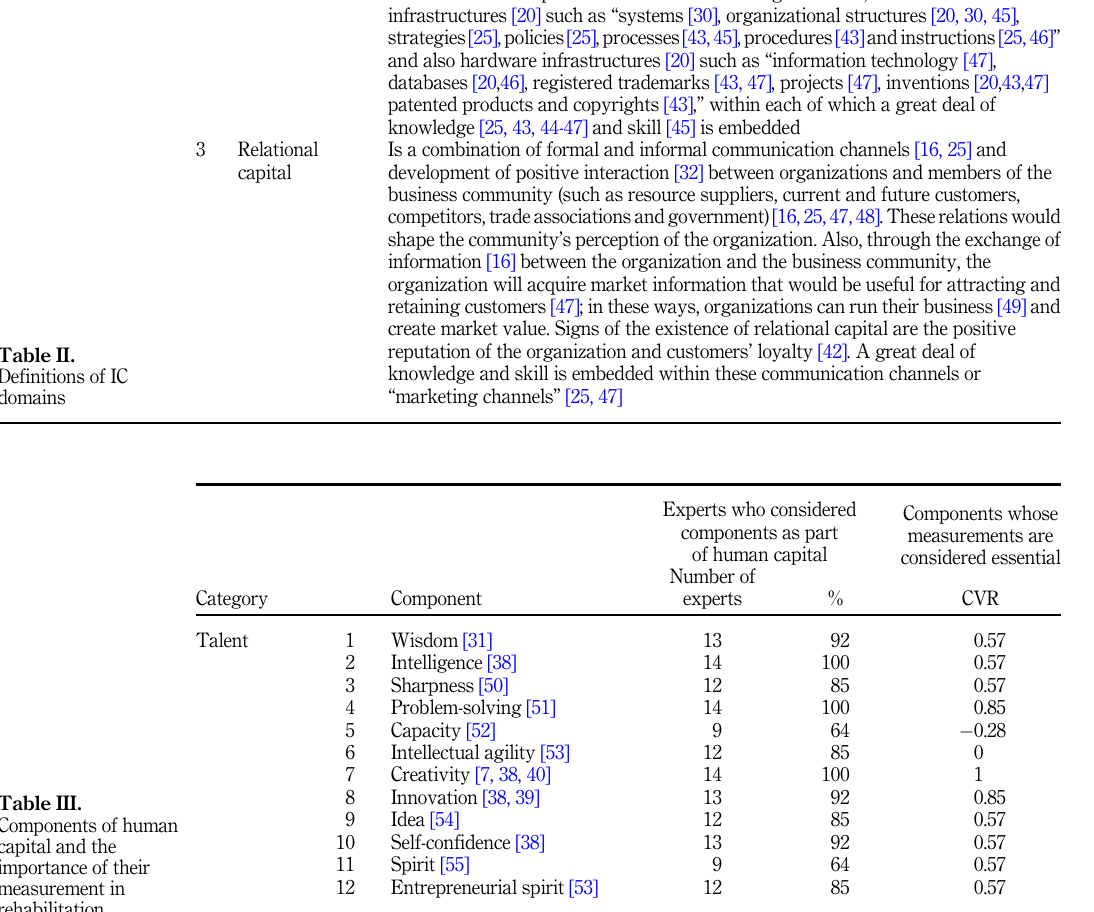
Table III. Components of human capital and the importance of their measurement in rehabilitation